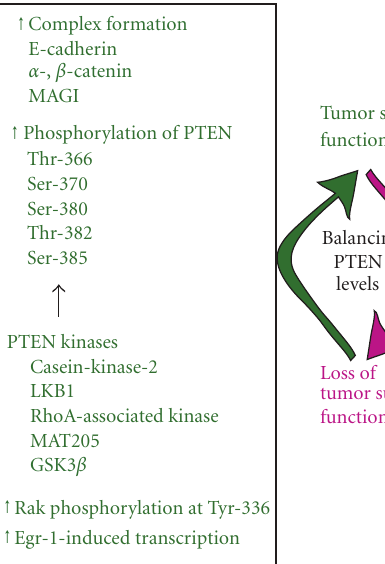
Figure 1: Mechanisms other than gene mutations and epigenetic silencing that regulate PTEN levels and ultimately its tumor suppressor